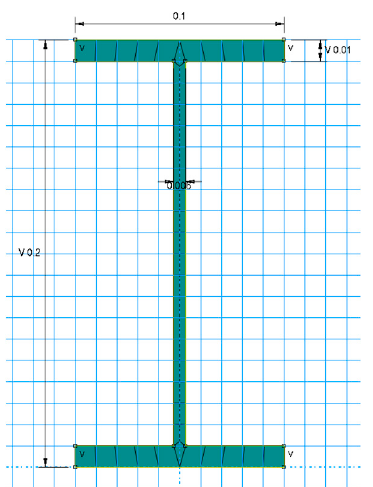
Figure 4. Geometry, loads and mechanical boundary conditions applied to the given beam.